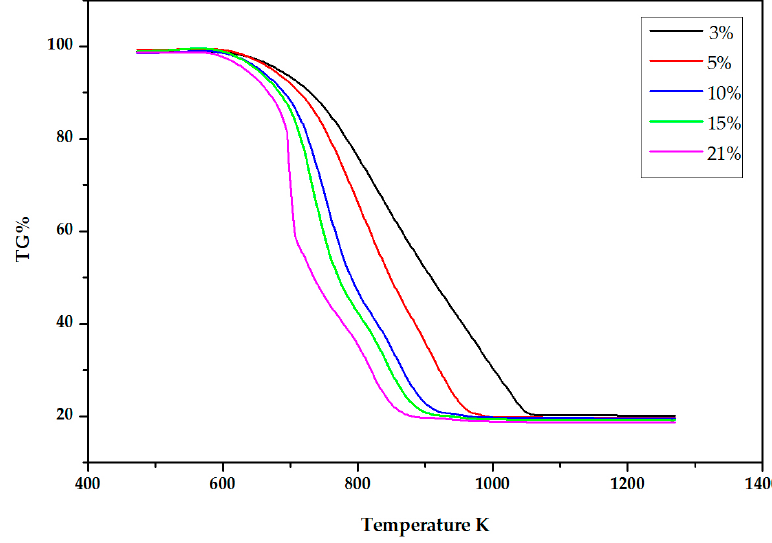
Figure 1. TG curves at different O 2 concentrations.